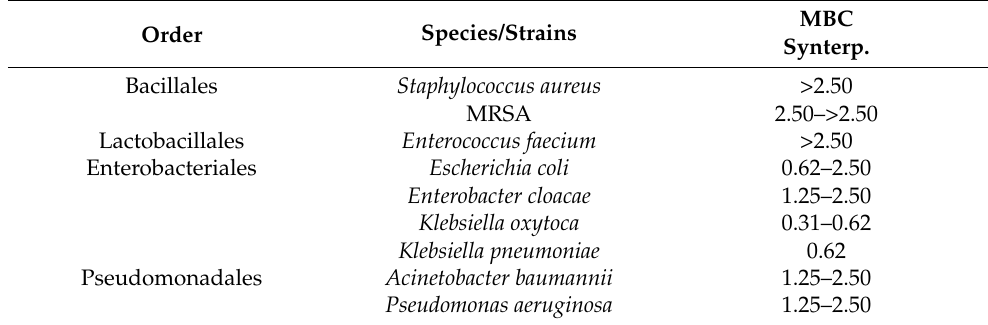
Table 5. Minimum bactericidal concentration (MBC) of Synterpicine™. MBC assays were performed on bacteria with already defined MICs. The range of concentrations tested is 0.00499–2.50% (v:v). Synterp.: Synterpicine™; MRSA: methicillin-resistant Staphylococcus aureus ( n =